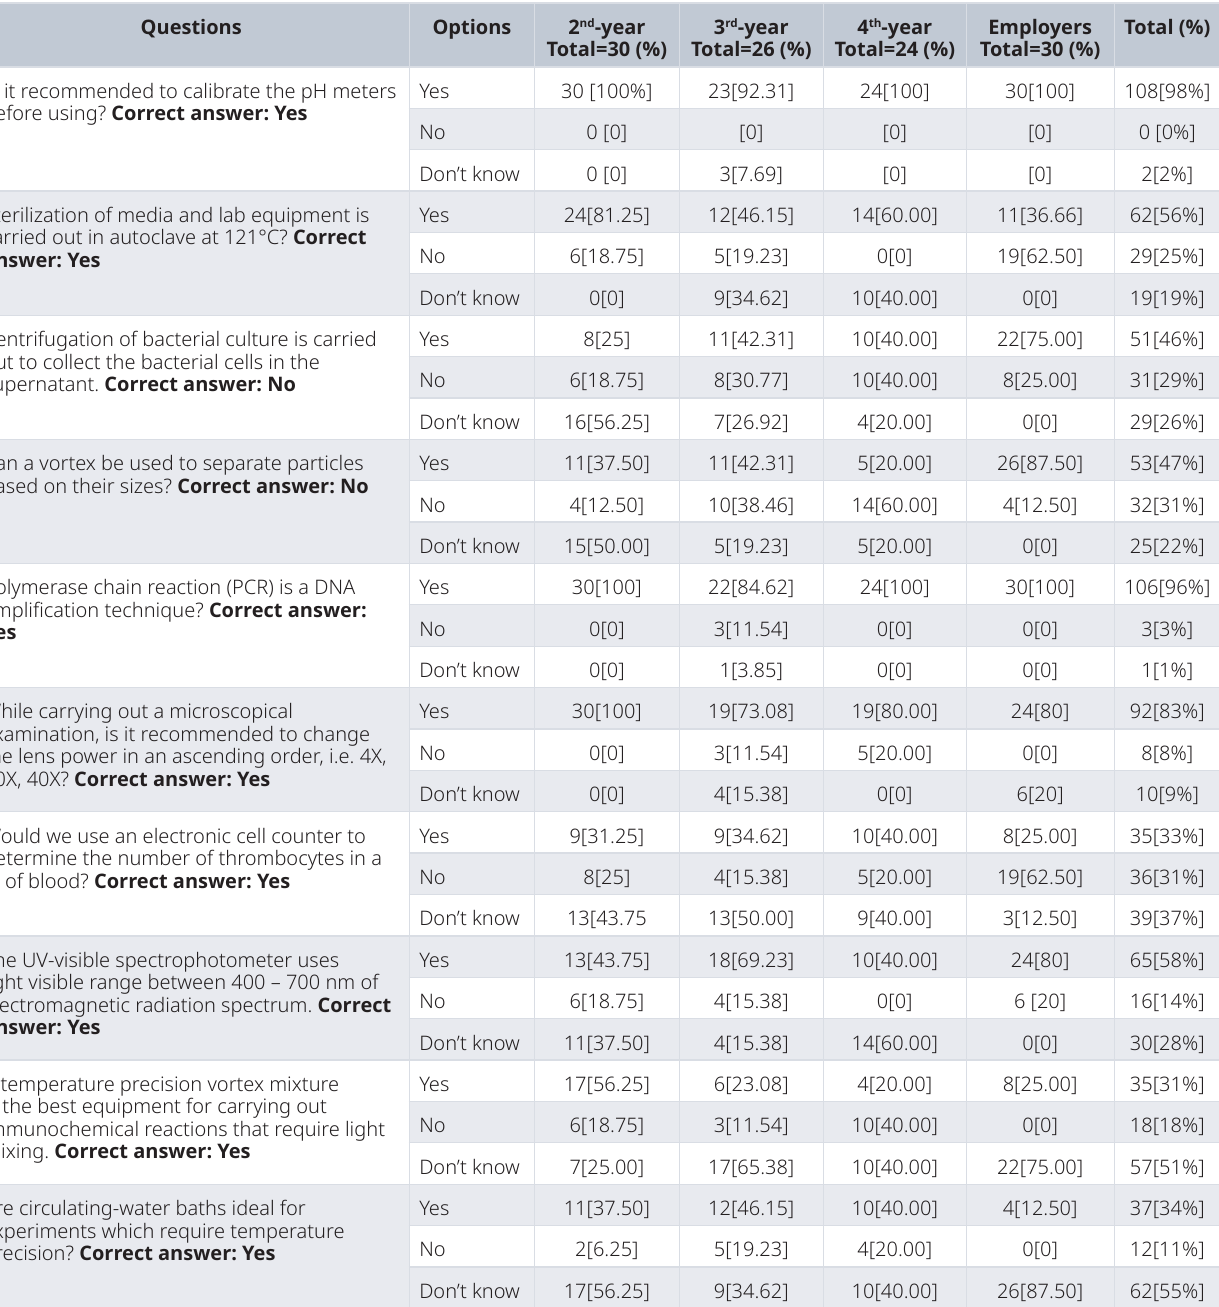
Table 1. Participant’ knowledge about microbiology laboratory equipment.